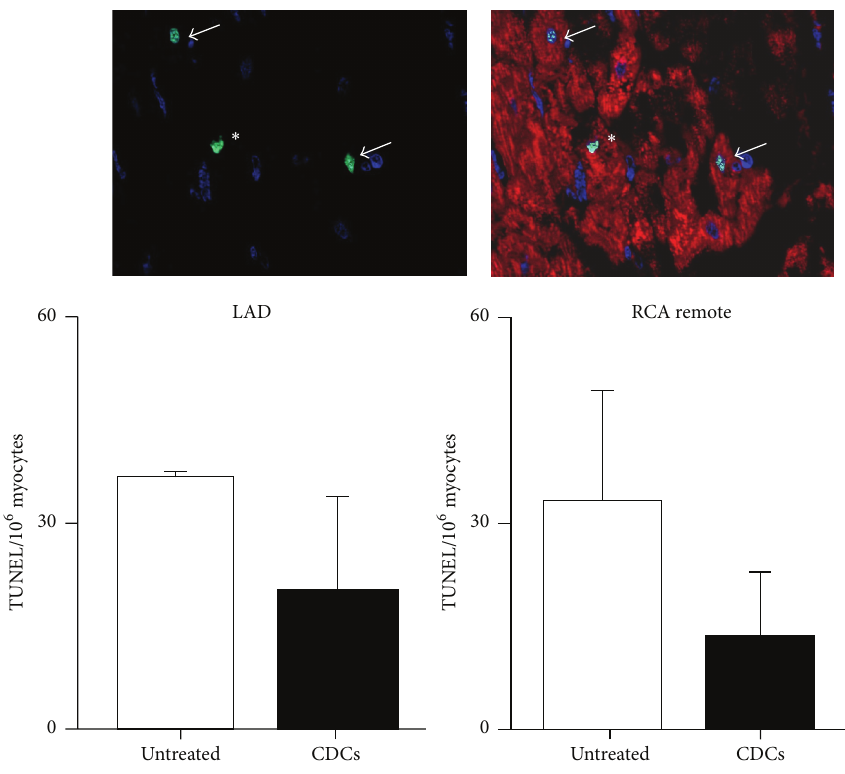
Figure6:TheeffectsofCDCsonTUNELpositivemyocytes.TheupperpanelrepresentsTUNELpositivenucleilocalizedincardiacmyocytes. Two TUNEL positive nuclei (green, arrow) localized to myocytes by cTnI staining (red). One TUNEL positive nonmyocyte nucleus located in the interstitial space ( ∗ ). The lower graph summarizes the number of TUNEL positive myocytes detected in the heart, expressed as nuclei per million myocytes. After CDCs, there was no significant change in the number of TUNEL positive myocytes in ischemic LAD and remote regions. Table 3: The effects of CDCs on echocardiographic